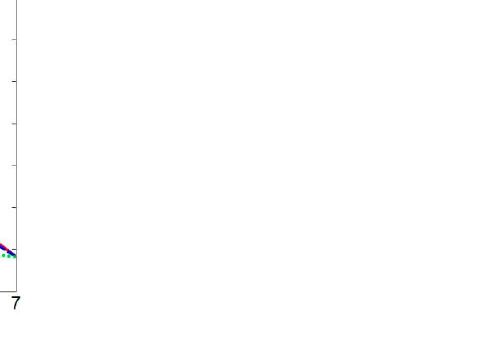
Figure 8. Average diffusion capacity per RBC for different RBC distribution and Hematocrit.